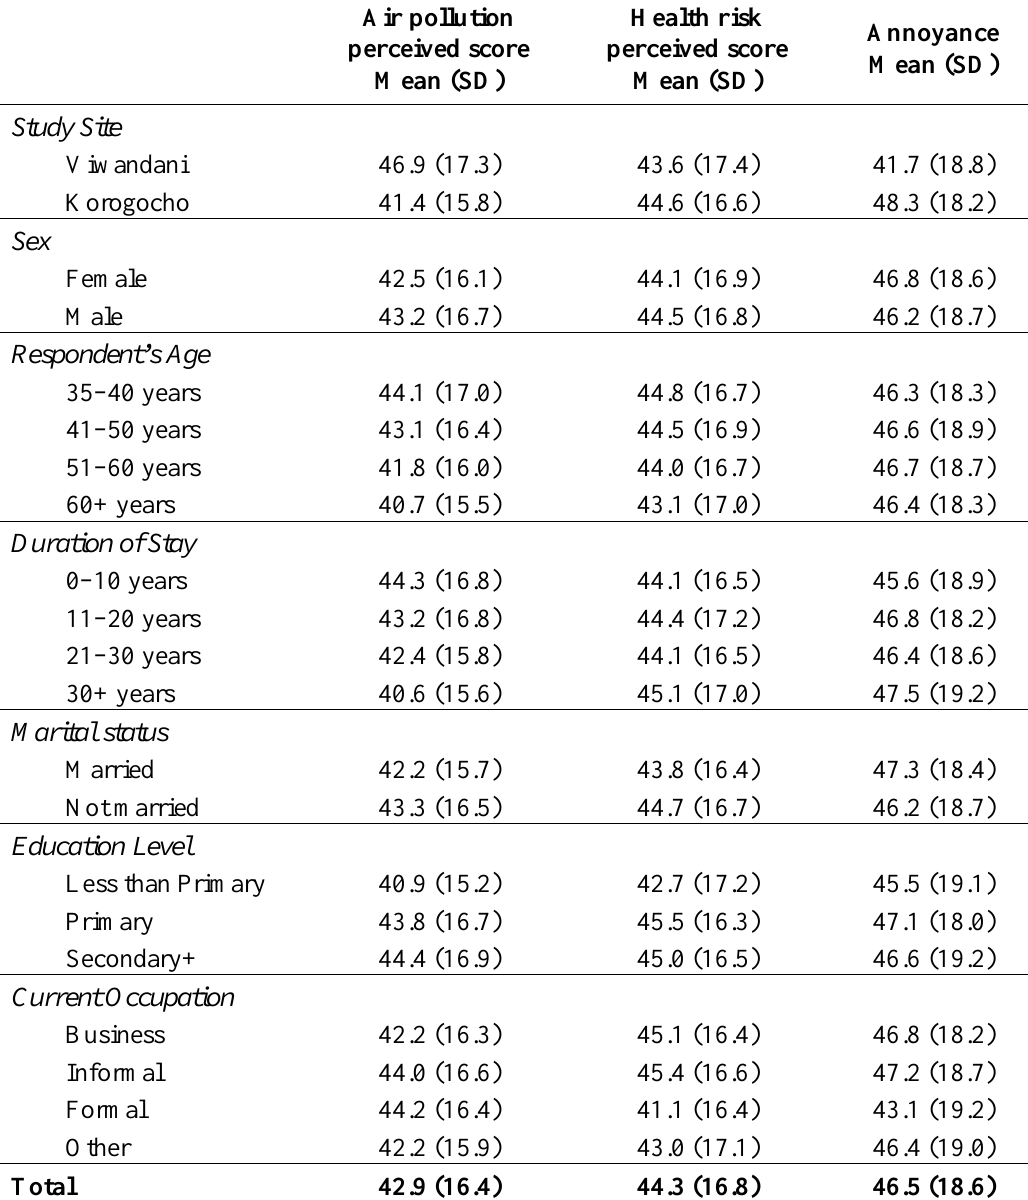
Table 4. Descriptive summary of the perceived scores by individual